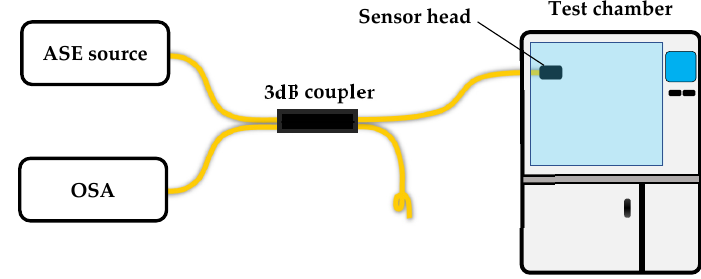
Figure 4. Schematic diagram of the experimental setup.